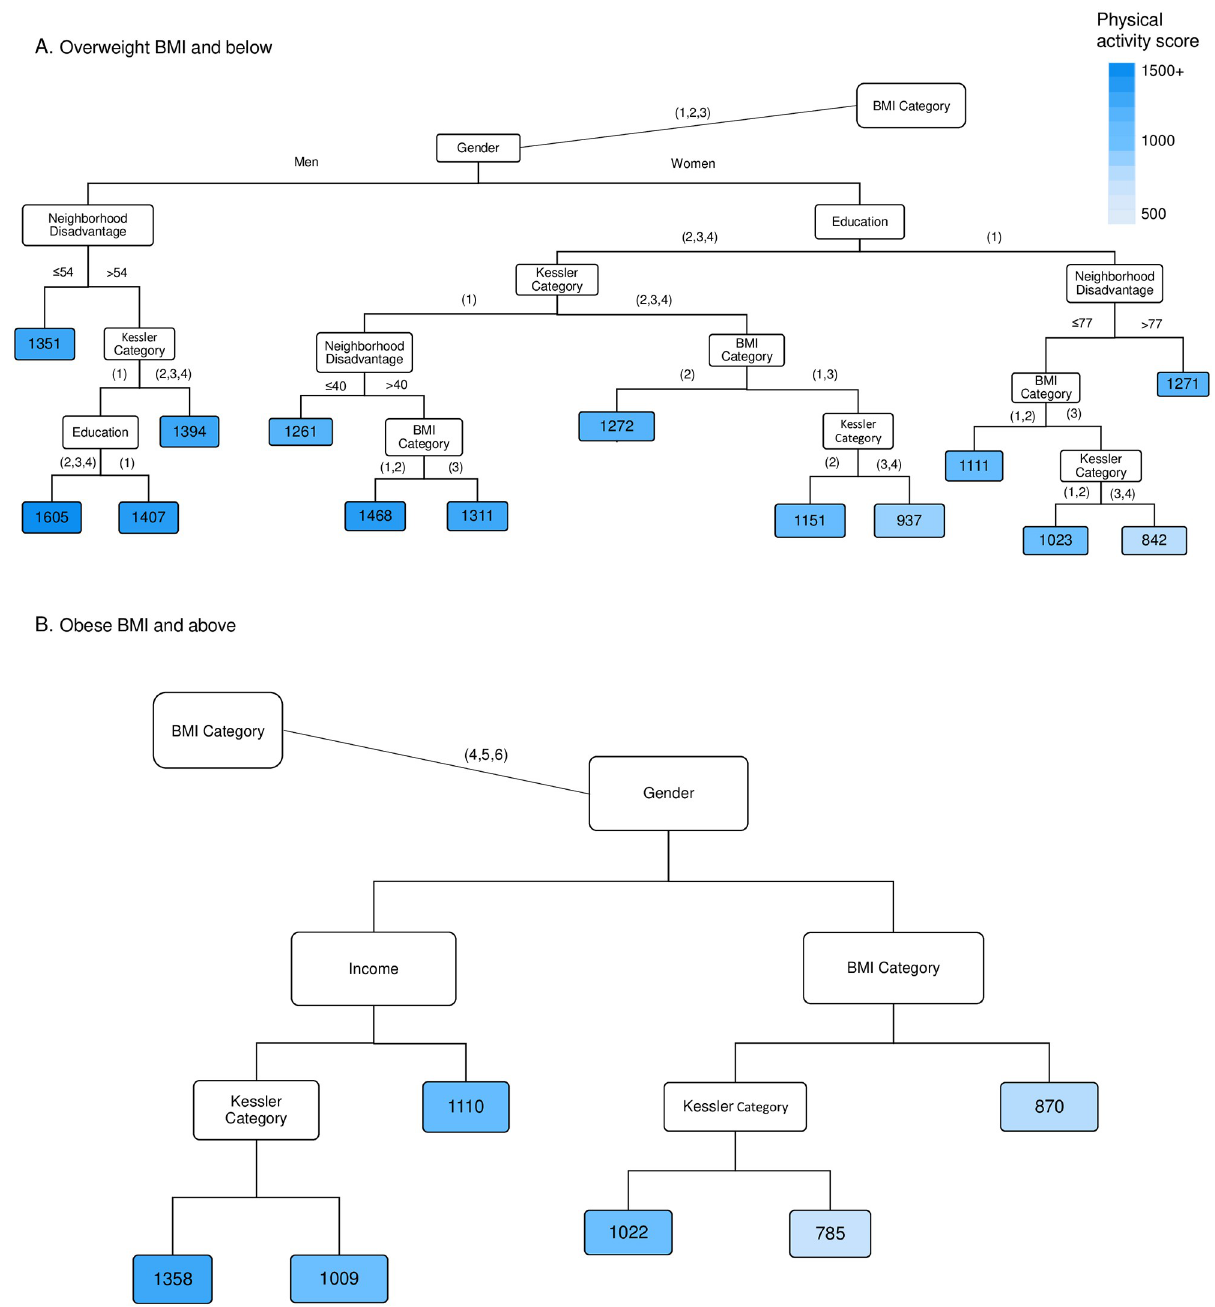
Fig 4. Factors affecting physical activity for respondents without diabetes (n = 7338). The terminal nodes show the average physical activity score in MET.min/week. Notes: BMI Category (1 = Underweight, 2 = Normal weight, 3 = Overweight, 4 = Obese 1, 5 = Obese 2, 6 = Obese 3); Education (1 = No post school qualification, 2 = Vocational, 3 = Diploma, 4 = Bachelor’s or higher); Kessler Category (1 = Low/none, 2 = Moderate,3 = High, 4 = Very high); Income (1 = < $25,999, 2 = $26,000–51,999, 3 = $52,000–72,799, 4 = $72,800–129,999, � $130,000, 6 = Don’t Know/ Don’t want to answer this); See methods for further details. Predicted Root Mean Square Error per individual and time = 1401 MET mins/week.